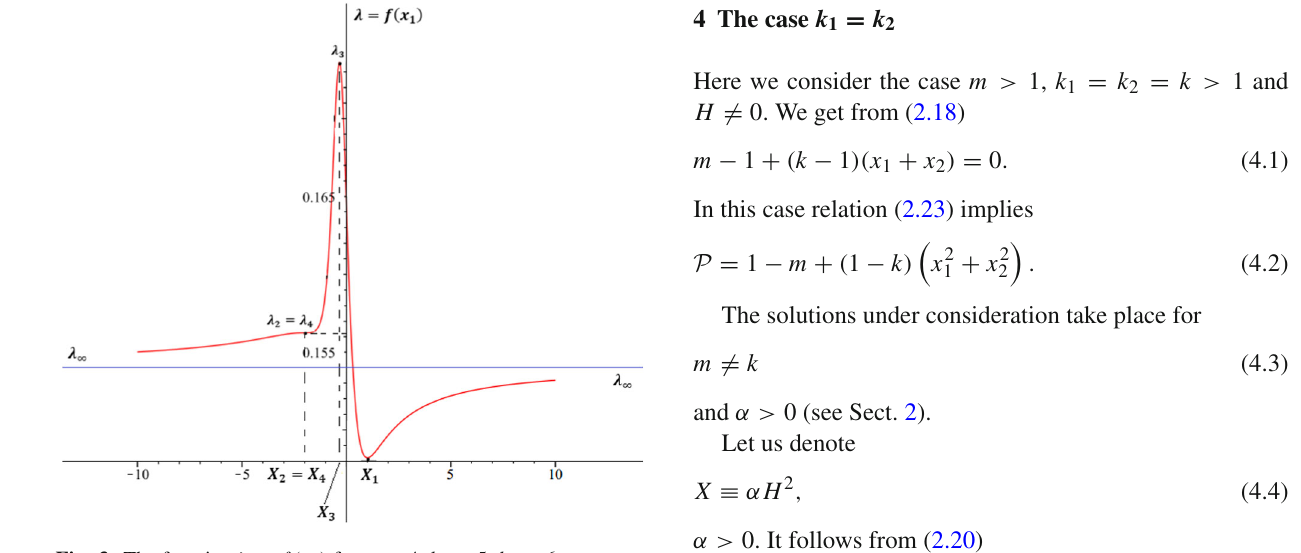
Fig. 3 The function λ = f ( x 1 ) for m = 4, k 1 = 5, k 2 =